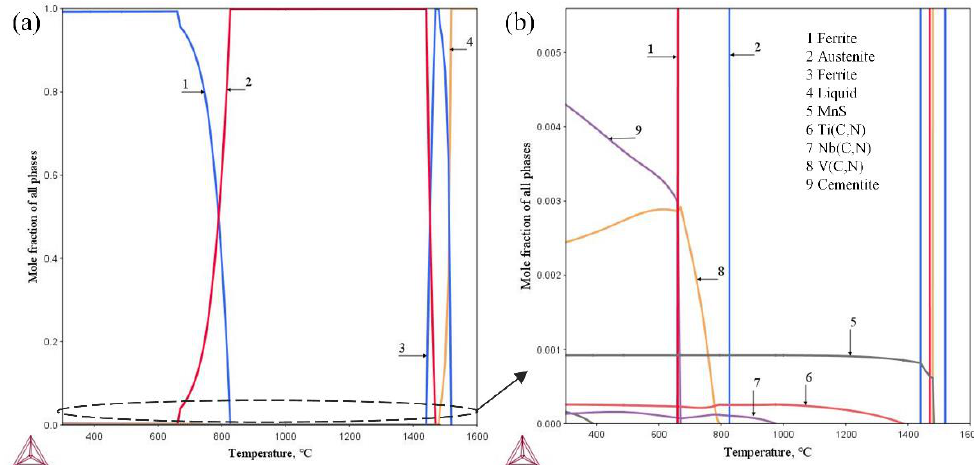
Figure 2. ( a ) Equilibrium all phases constituents predicted by Thermal-Calc software for Nb-V-Ti free-cutting steel, ( b ) Partially enlarged view at dotted line.